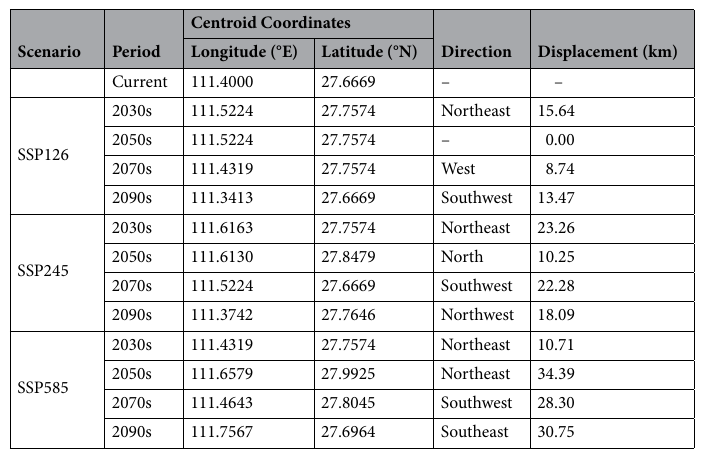
Table 4. Shift distance and direction of mean centre of different suitable areas of N. californicus